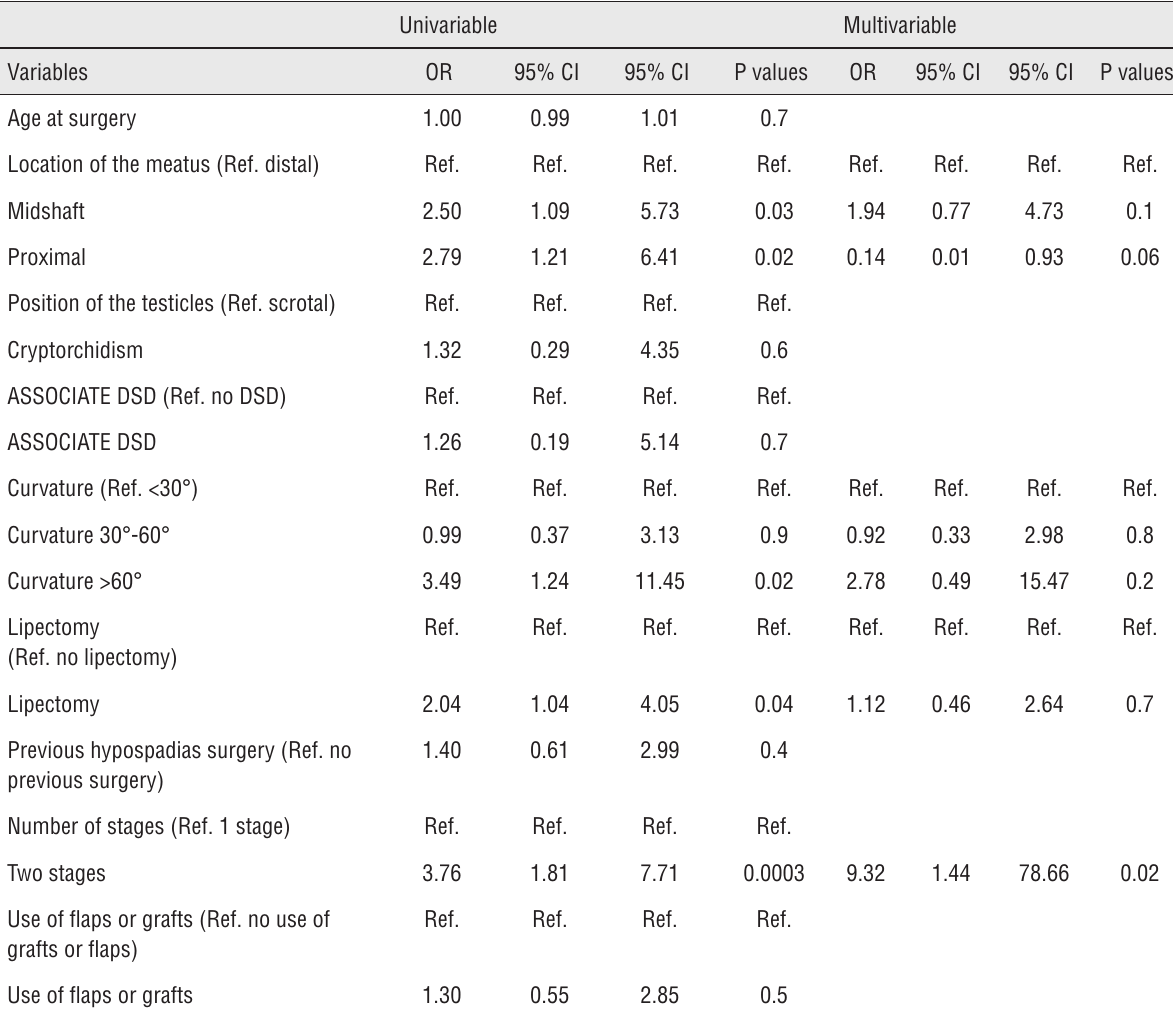
Table 3 - Univariable and multivariable logistic regression models testing for fistula in patients treated with or without pubic lipectomy, within 266 patients treated for hypospadias. Univariable Multivariable Variables OR 95% CI 95% CI P values OR 95% CI 95% CI P values Age at surgery 1.00 0.99 1.01 0.7 Location of the meatus (Ref.